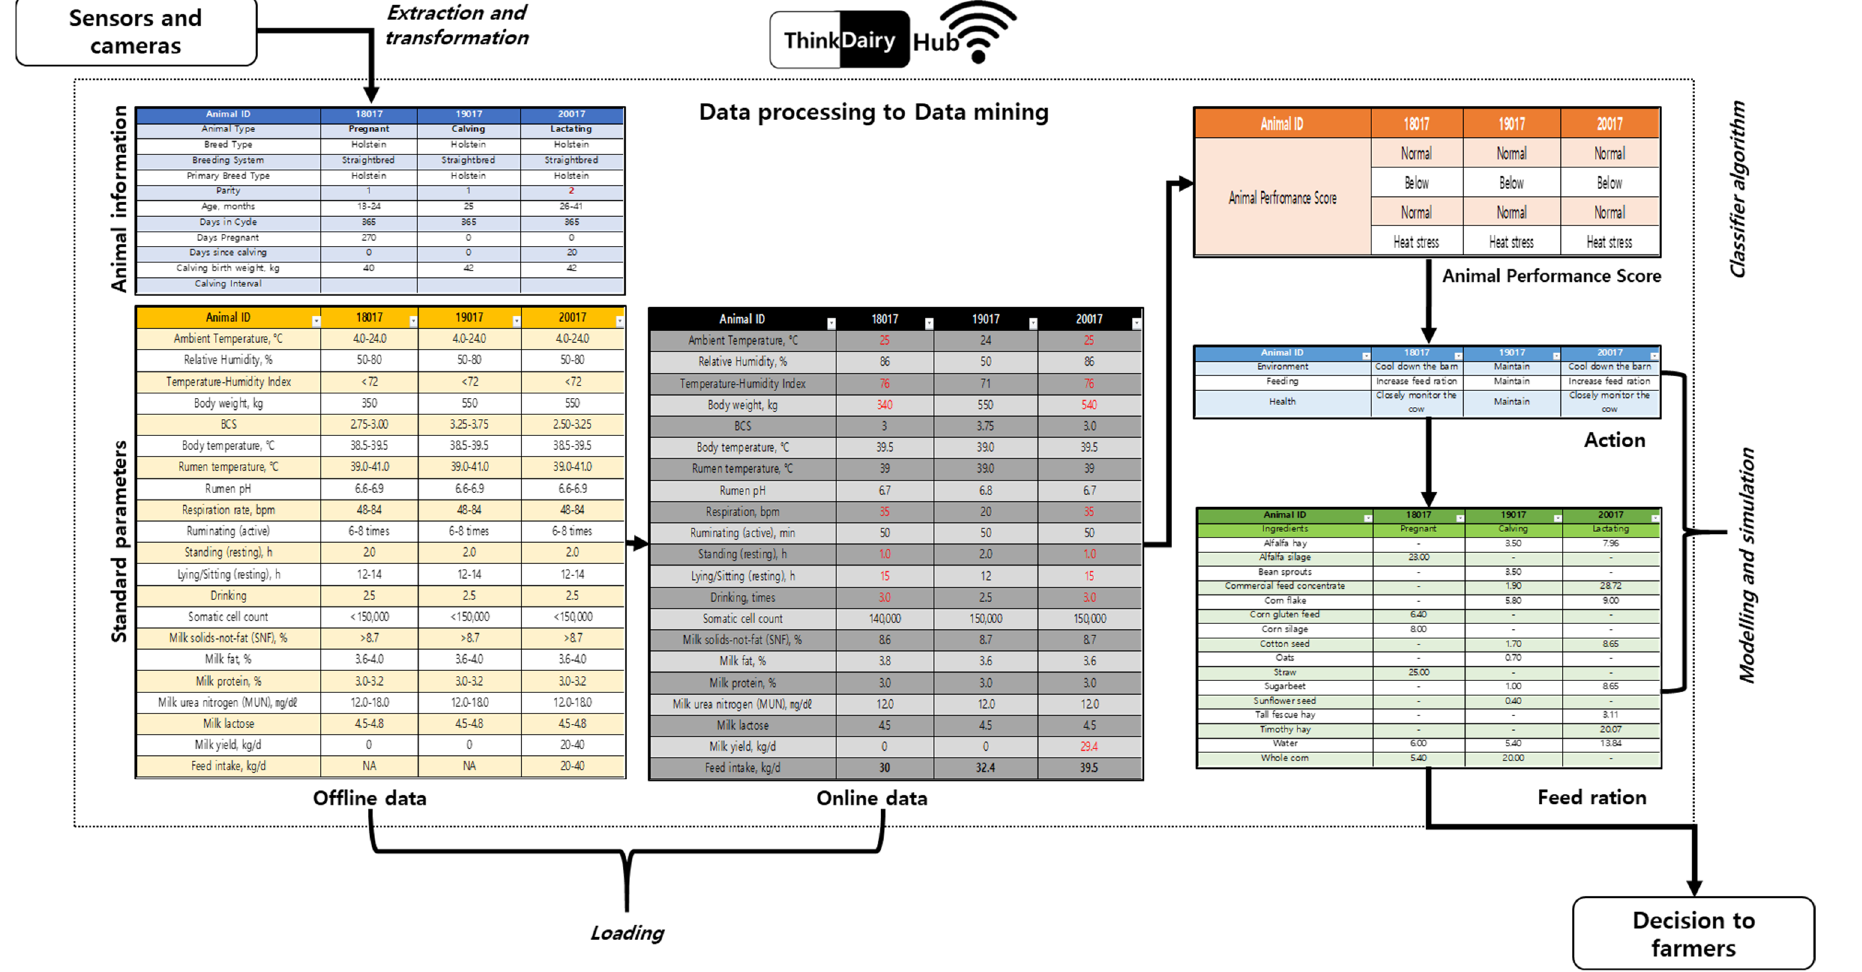
Figure 2. Theoretical Framework of the proposed ThinkDairy data-mining hub.